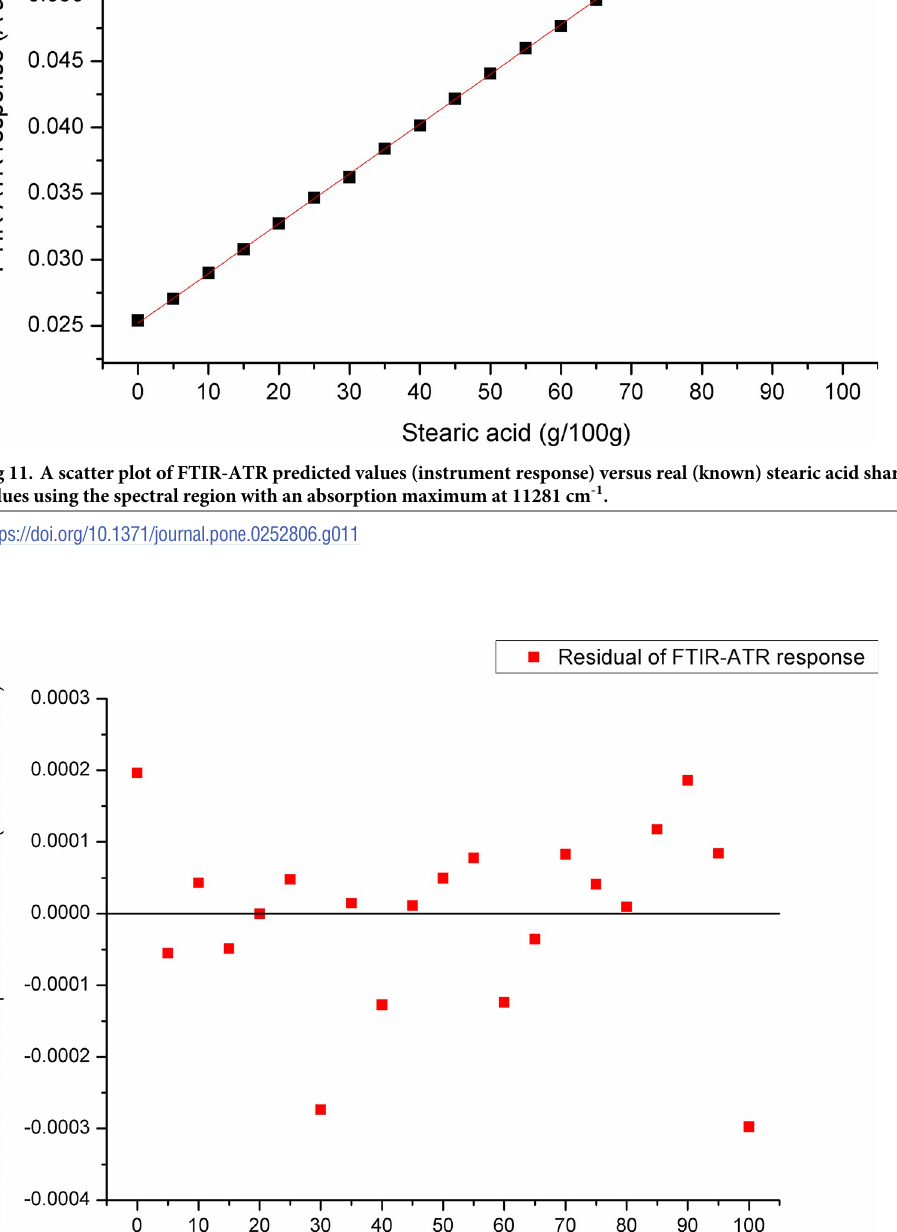
PLOS ONE | https://doi.org/10.1371/journal.pone.0252806 September 9,